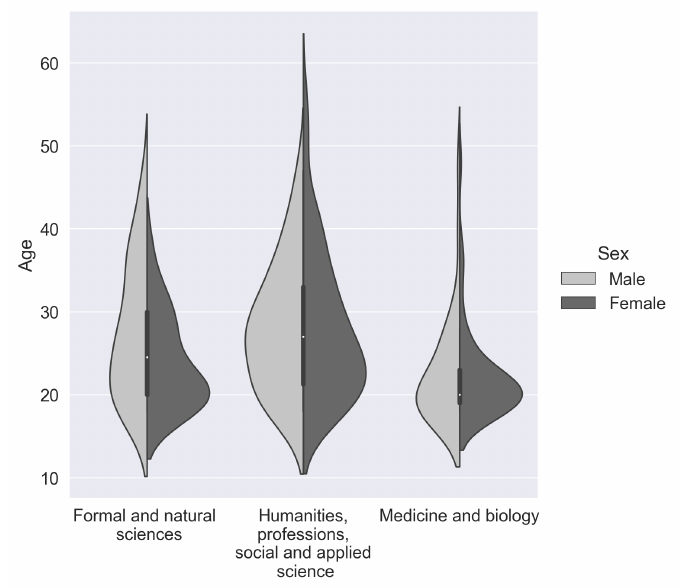
Figure 1. Subjects, grouped by age, education (bachelor degree or higher—left plot, undergraduate and secondary special education—right plot), gender, and professional area of current